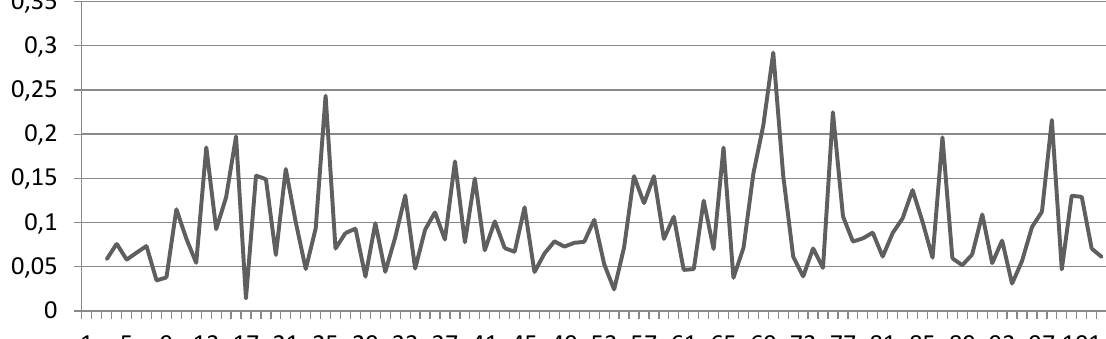
Figure 1. Dhofar University DSCR: debt service cover ratio – Monte Carlo simulation